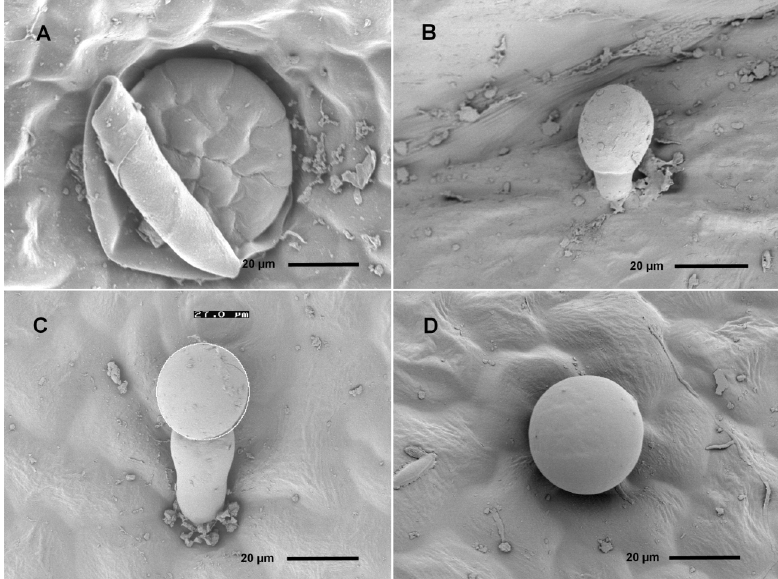
Fig. 1: Glandular trichomes of Origanum vulgare L. accessions. A) Peltate glandular trichome, in the picture the secretory head cells and the cuticular layer are visible. B) Capitate glandular trichome type I with one basal cell, one stalk cell and one head cell. C) Capitate glandular trichome type II with one basal cell, two stalk cells and one head cell. D) Capitate glandular trichome with a big head